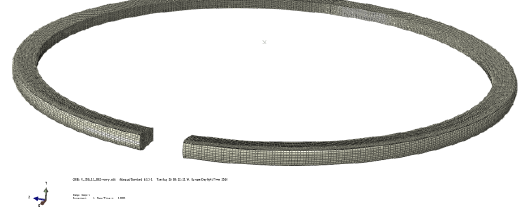
Fig. 4. The discreet form a ring geometry of an exemplary EMD 645E - mesh FEM